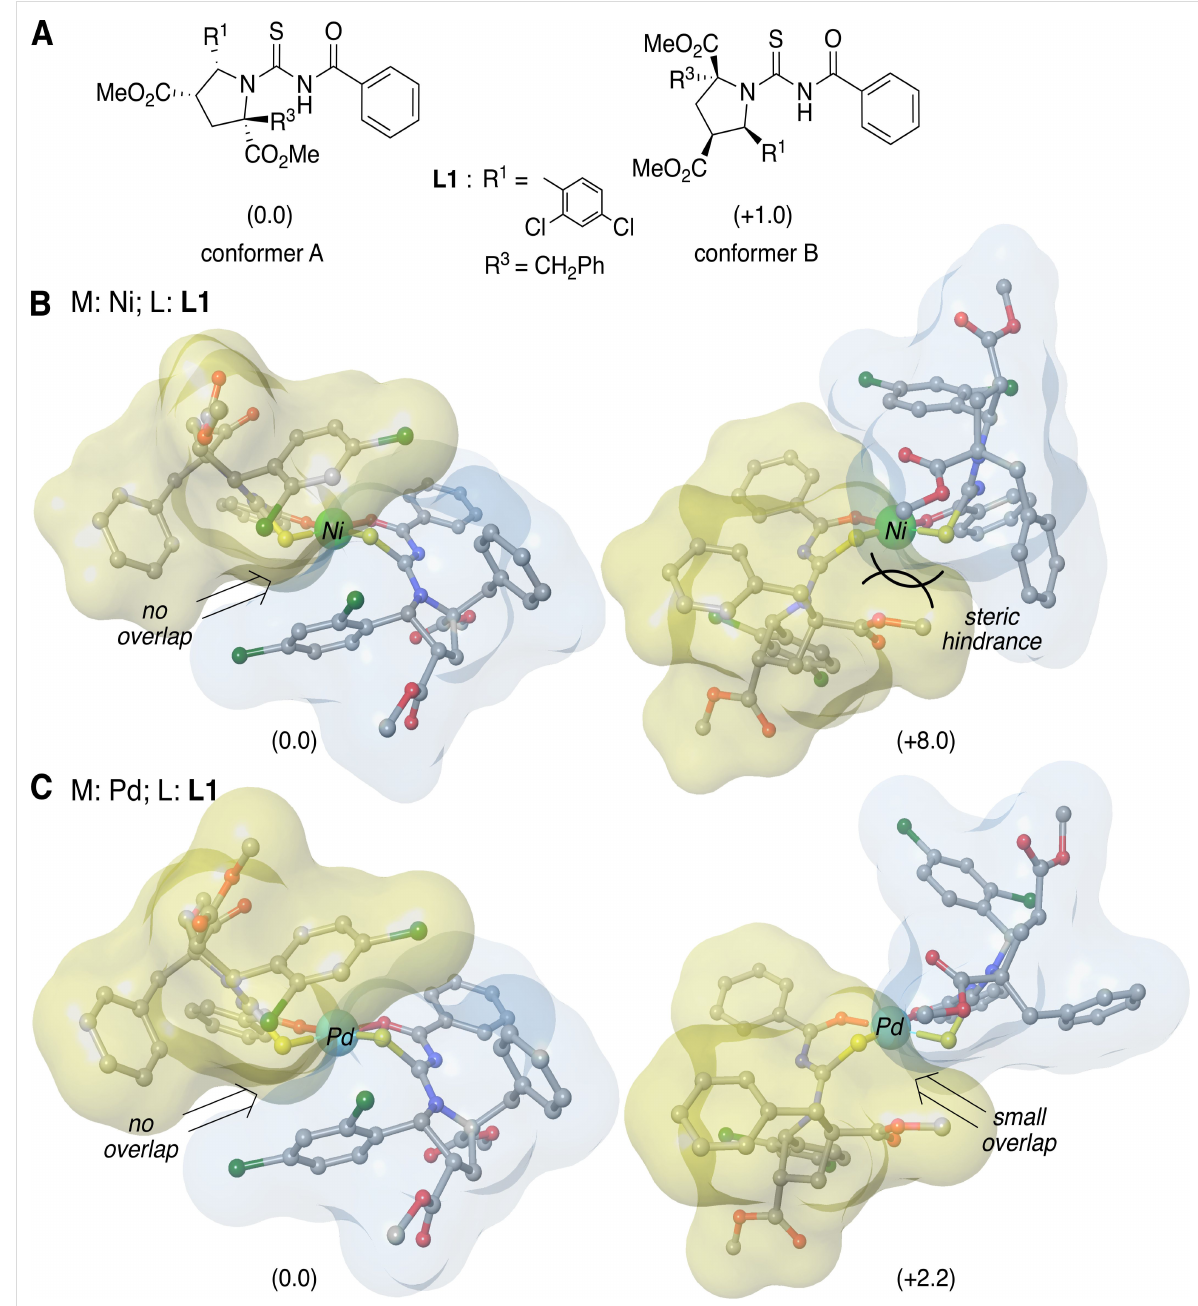
Figure 1: Main geometrical features and the relative energies (in kcal·mol –1 ) of (A) ligand L1 , (B) nickel- and (C) palladium complexes. Blue and yellow surfaces represent the solvent accessible surface of ligands with a probe radius of 1.4 Å. Hydrogen atoms are omitted for clarity.